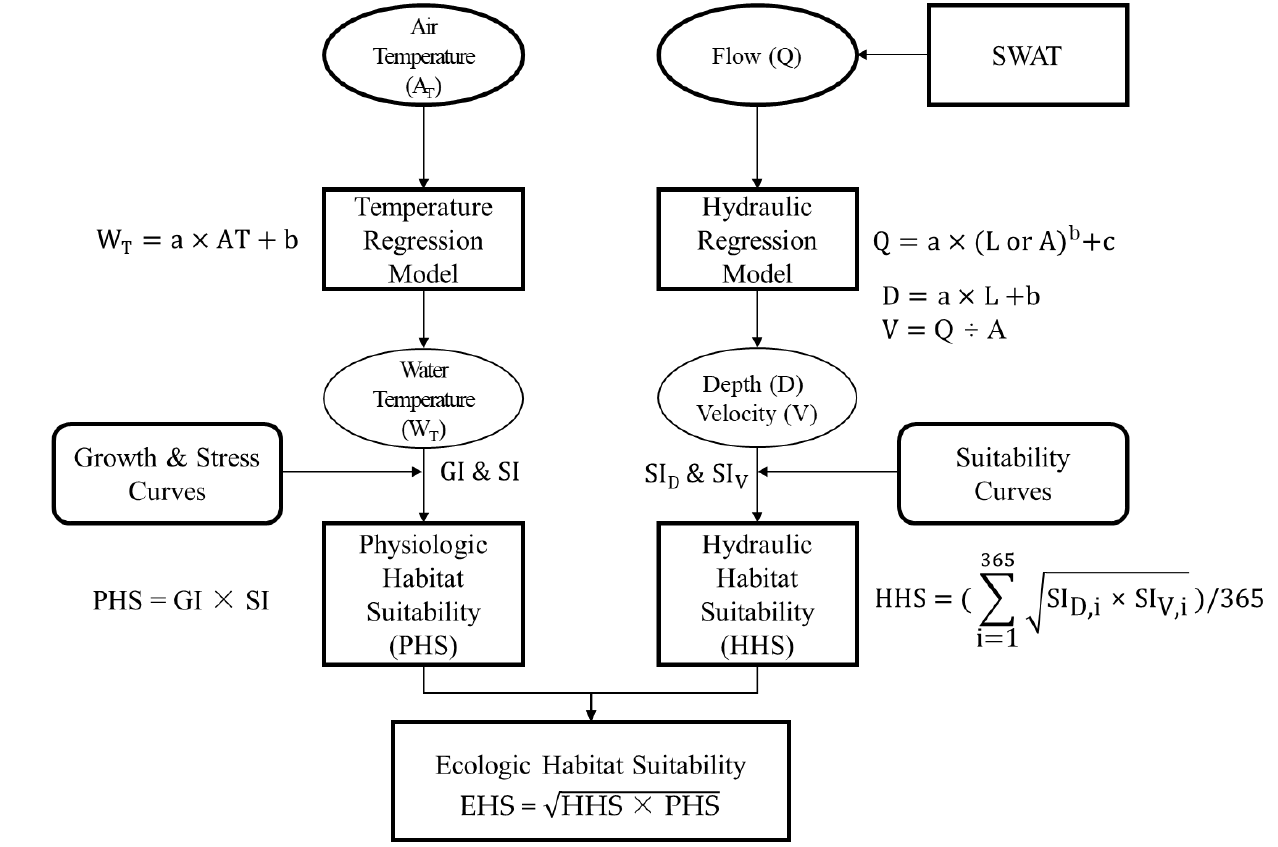
Figure 4. Schematic diagram of habitat suitability modeling used in this study (modified from the work of Shim et al. [33]).